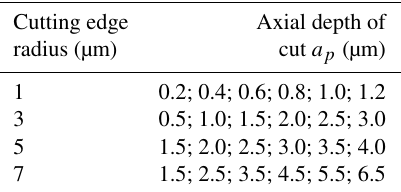
Table 4. Parameter selection for the end cutting